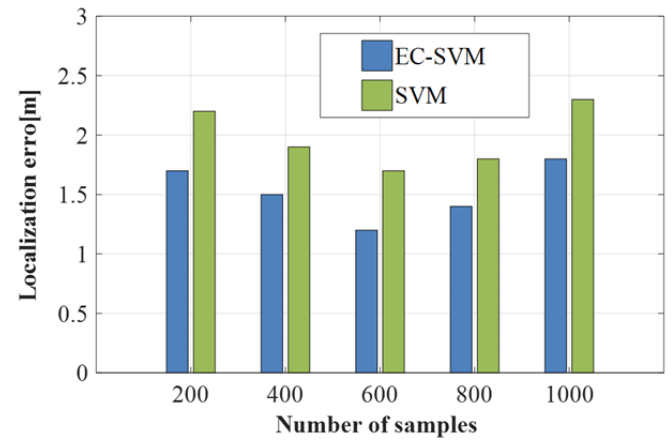
Figure 11. Comparison of optimized SVM with traditional